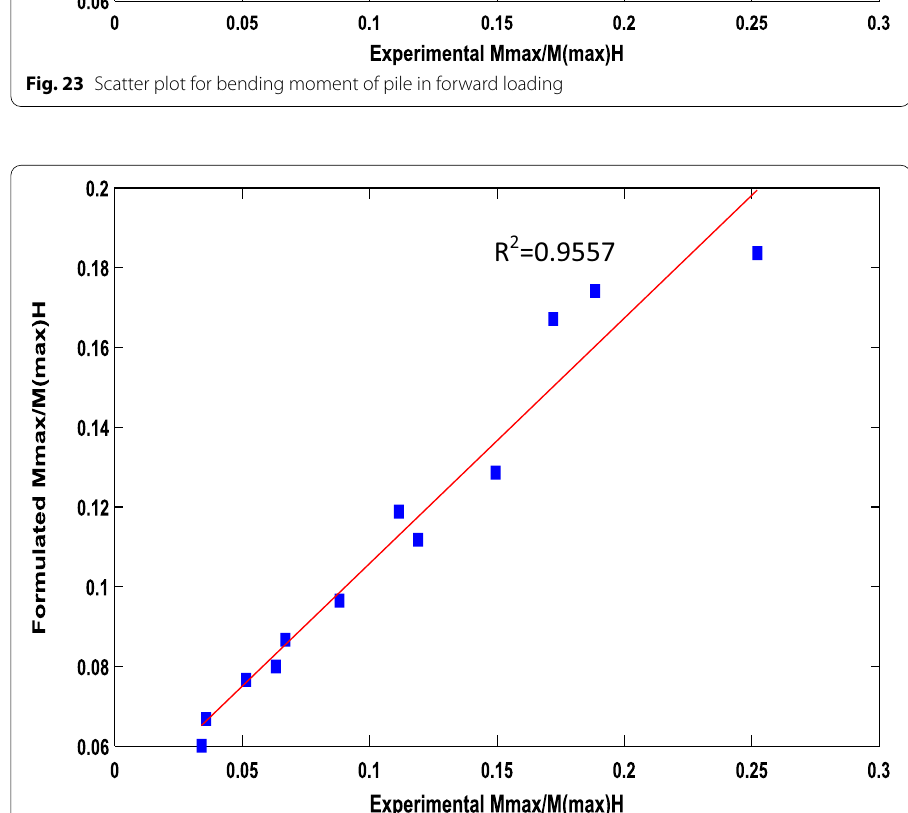
Fig. 24 Scatter plot for bending moment of pile in reverse